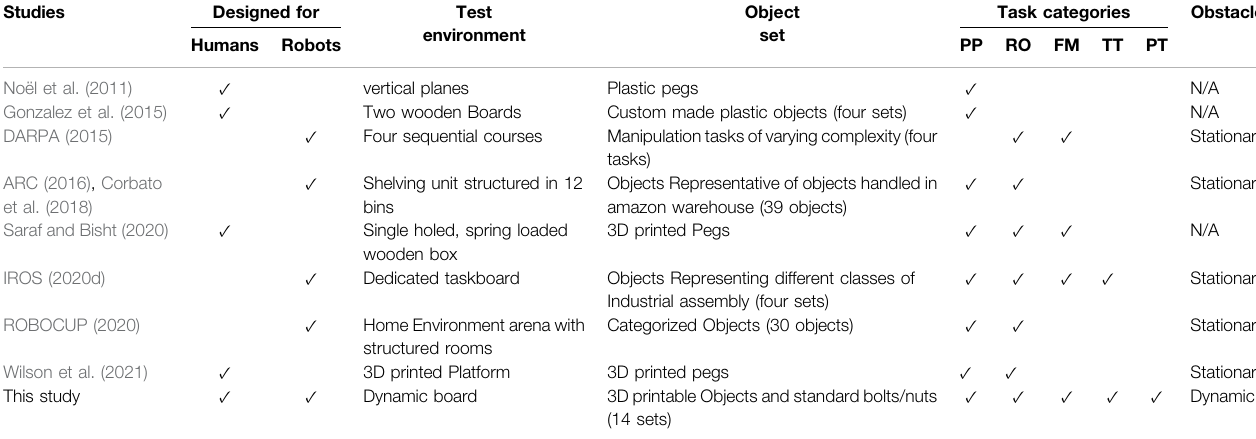
TABLE 3 | Table comparing the test environment, object sets, and features being evaluated across various dexterity tests proposed in recent literature. Studies